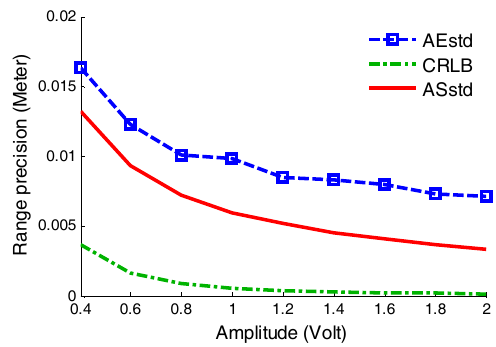
Figure 12. Range precision comparison results for pulse amplitude. AEstd is the amplitude-based experimental StD and ASstd is the amplitude-based simulation StD. CRLB means the Cramer–Rao Lower Bound on range estimates from Equation (19).